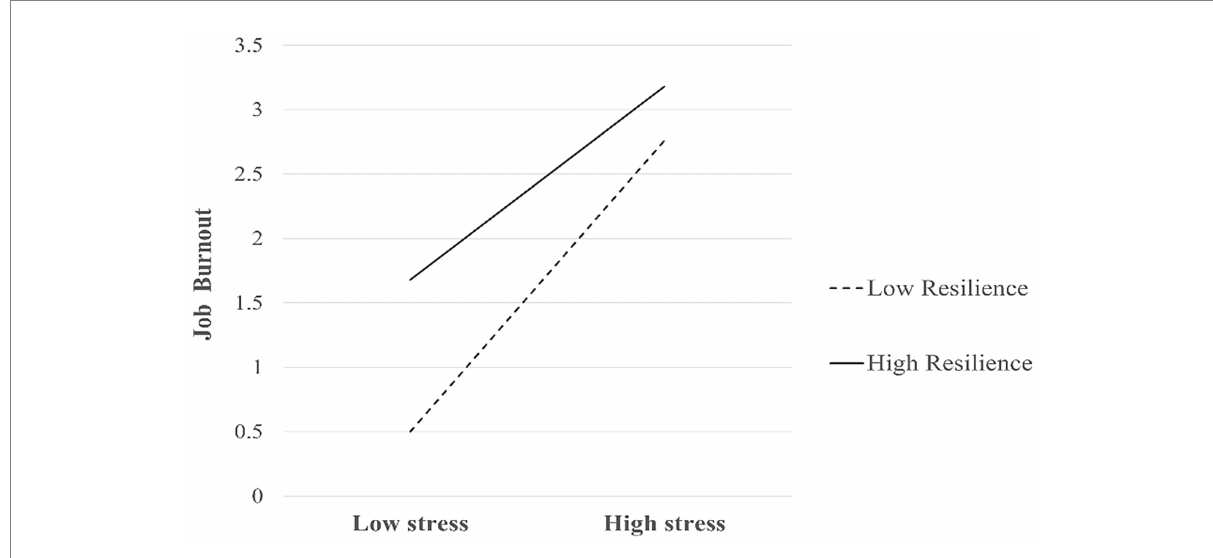
FIGURE 2 Resilience as a mediator between job stress and